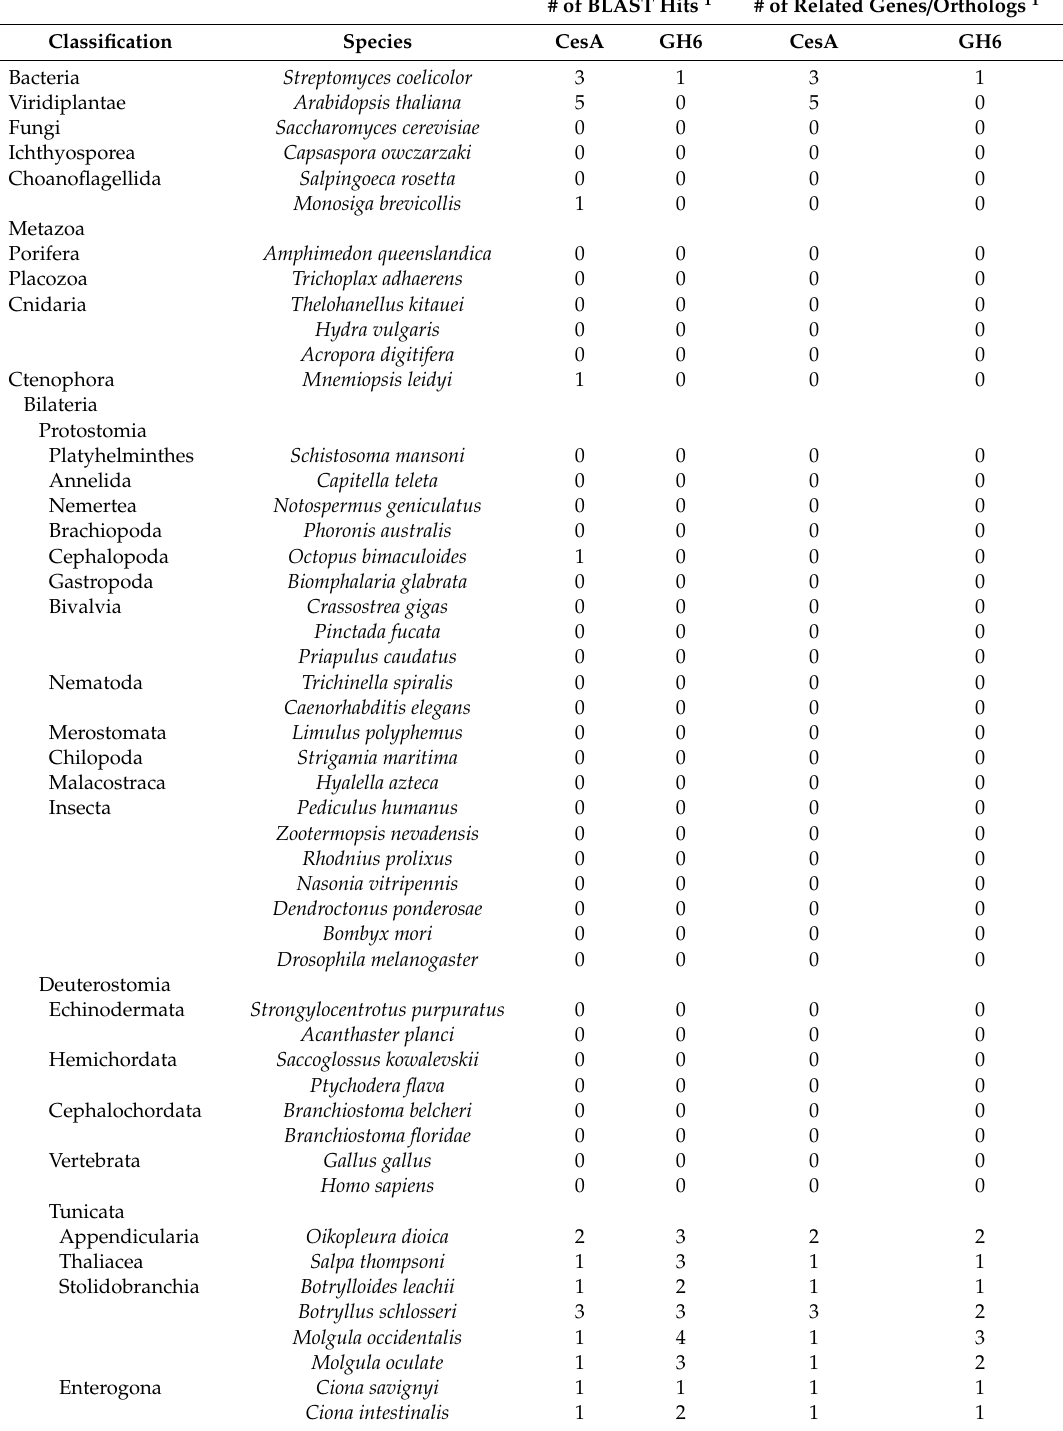
Table 1. Number of related genes / orthologs of tunicate CesA CesA and GT6 domains found in the ORTHOSCOPE